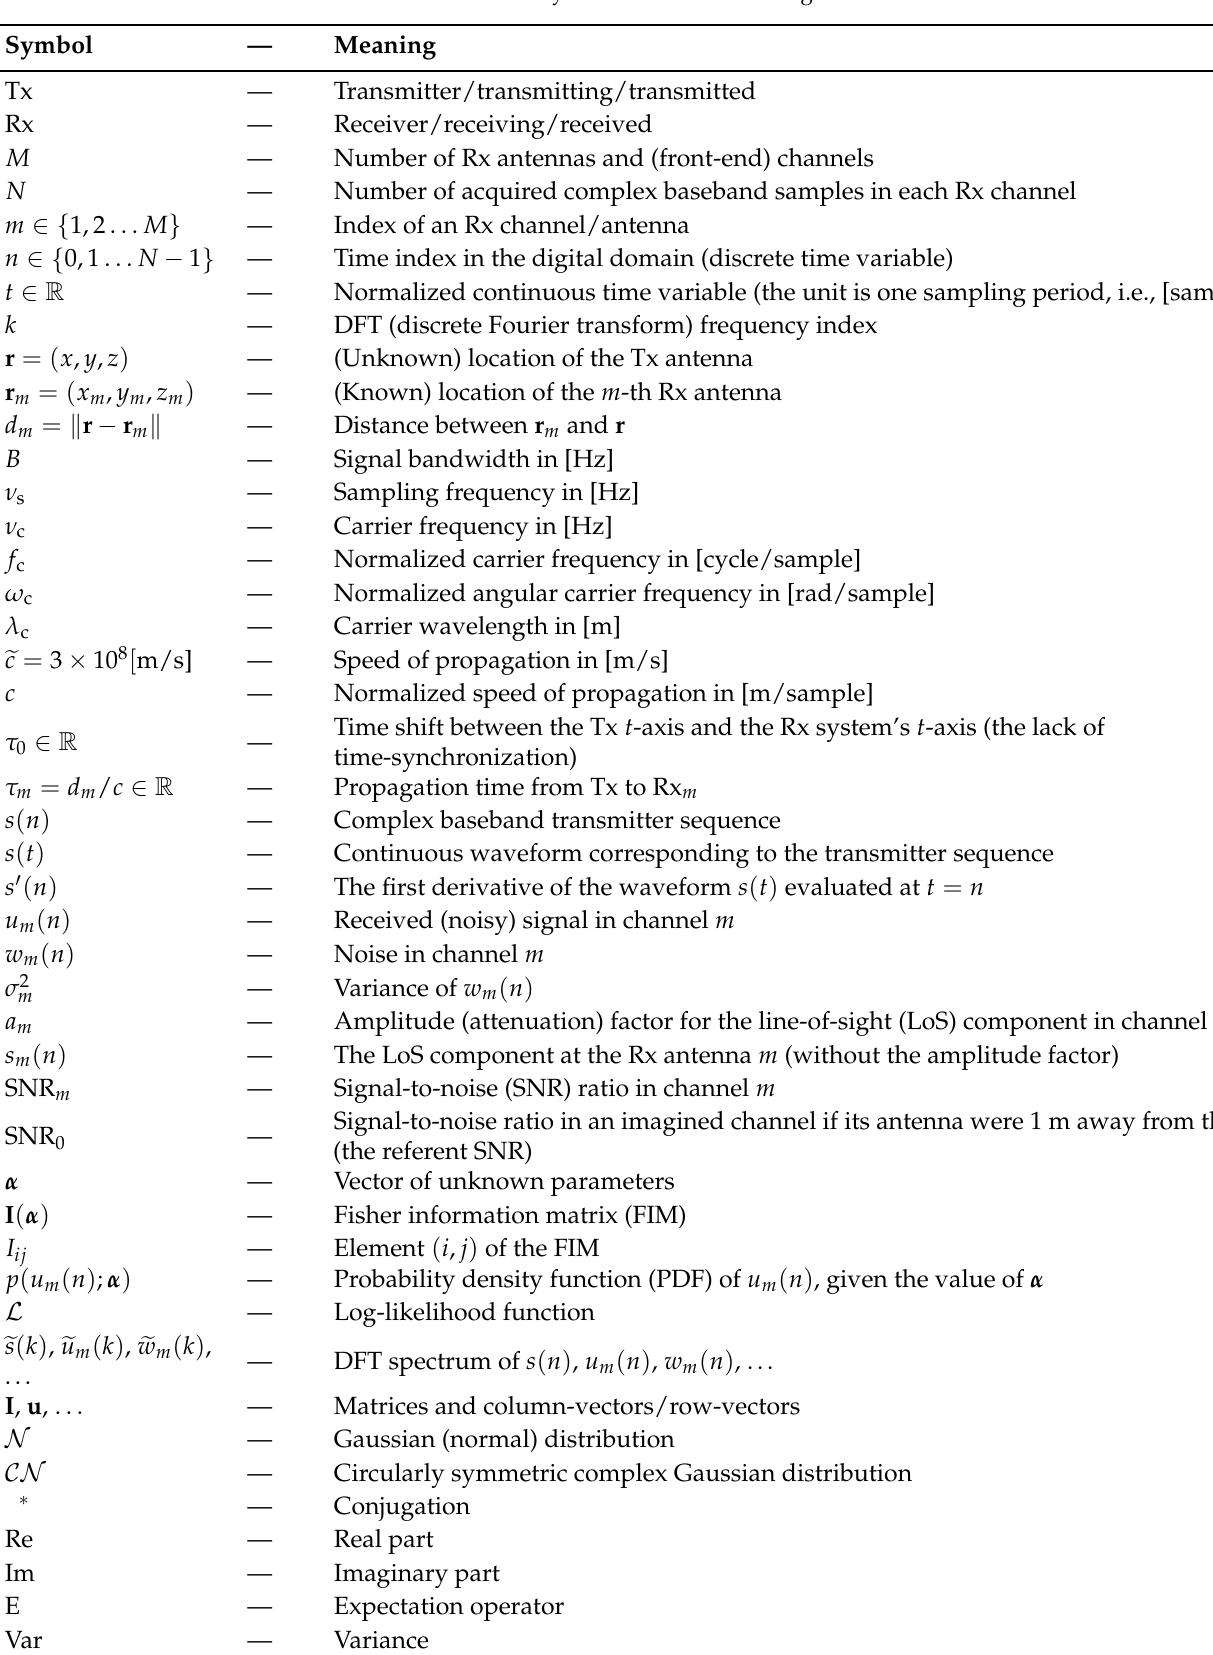
Table 1. Symbols and their